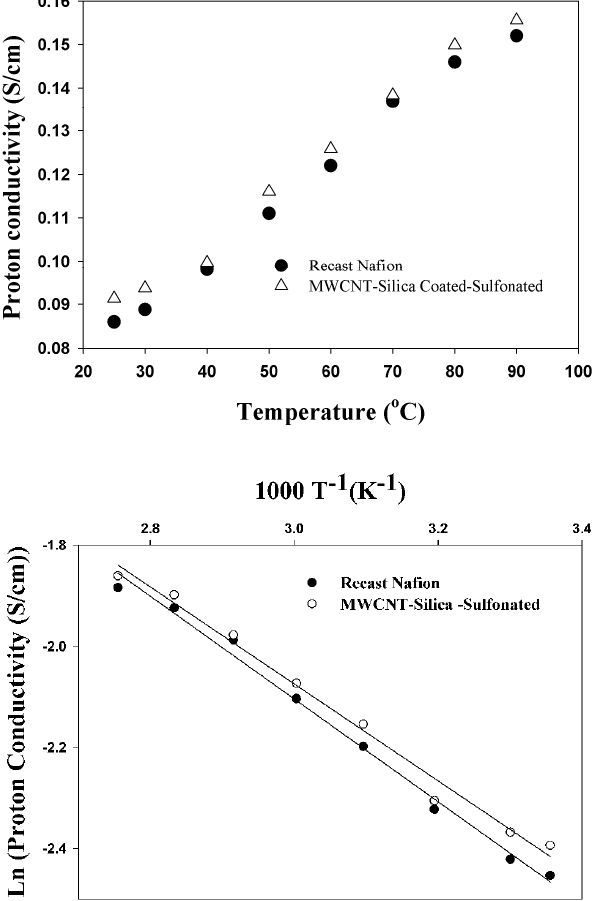
Fig. 4. (a) Proton conductivity of Nafion/CNT@SiO 2 -SO 3 H in the temperature range of 25-90 °C in comparison with recast Nafion. (b) Demonstrates the Arrhenius amount of proton conductivity for Nafion/CNT@SiO 2 -SO 3 H in comparison with recast